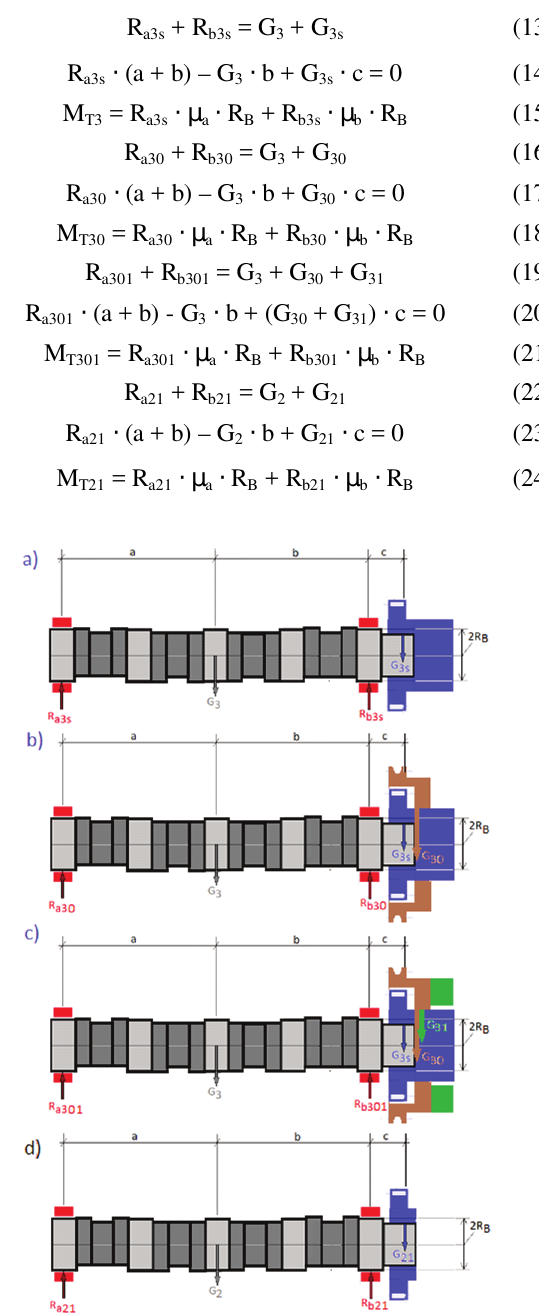
Fig. 4. Model for loading the bearing in the assembly containing: a) inlet camshaft, phaser and sprocket, b) inlet camshaft, phaser, sprocket and pulley, c) inlet camshaft, phaser, sprocket, pulley and heavy ring, d) outlet camshaft and